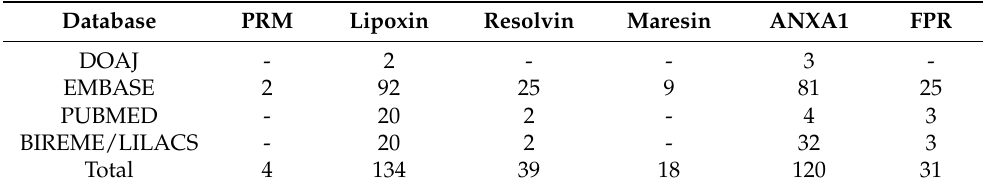
Table 1. Articles captured in the database and grouped according to the main observed mediators.